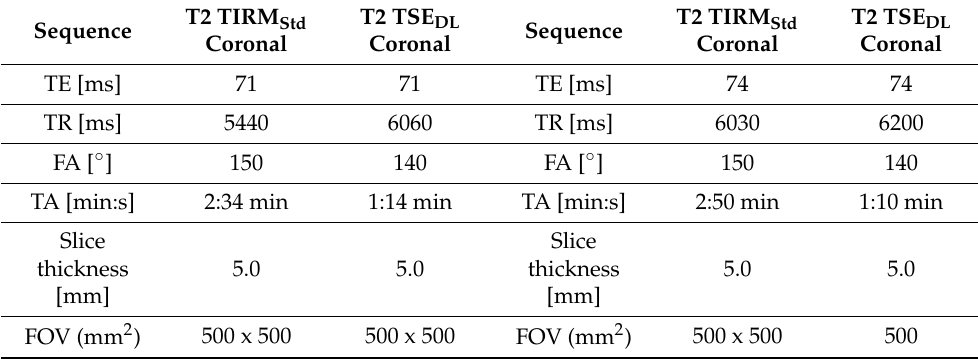
Table 2. Acquisition parameters for upper extremities at 1.5 T and 3